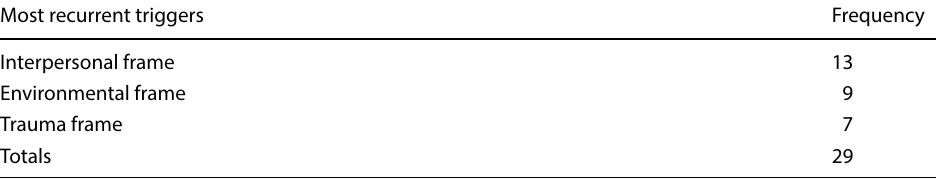
Table 3 Frequencies of the frames comprising the most recurrent triggering